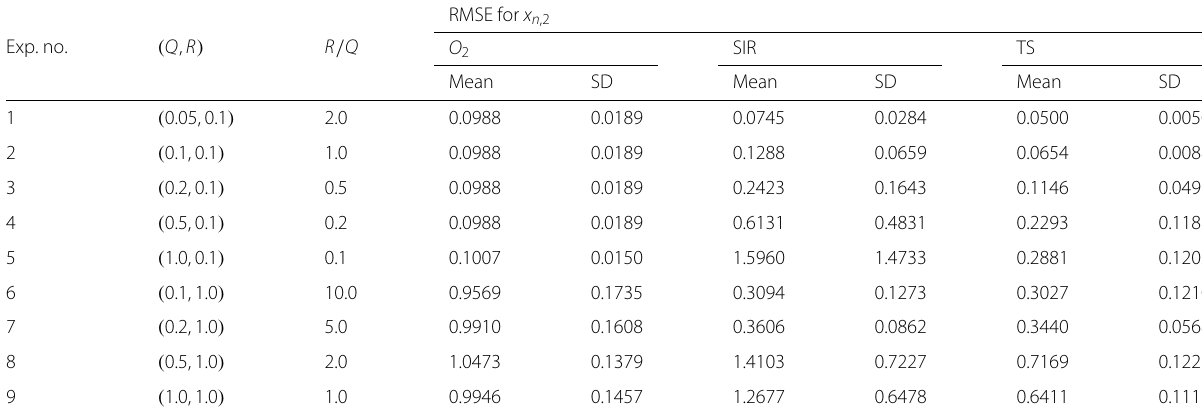
Table 8 Simulation results for Example 2: Mean and standard deviations of the RMSE for three different estimators of x n ,2 , namely, O 2 , the posterior mean based on SIR and the posterior mean based on TS Exp.